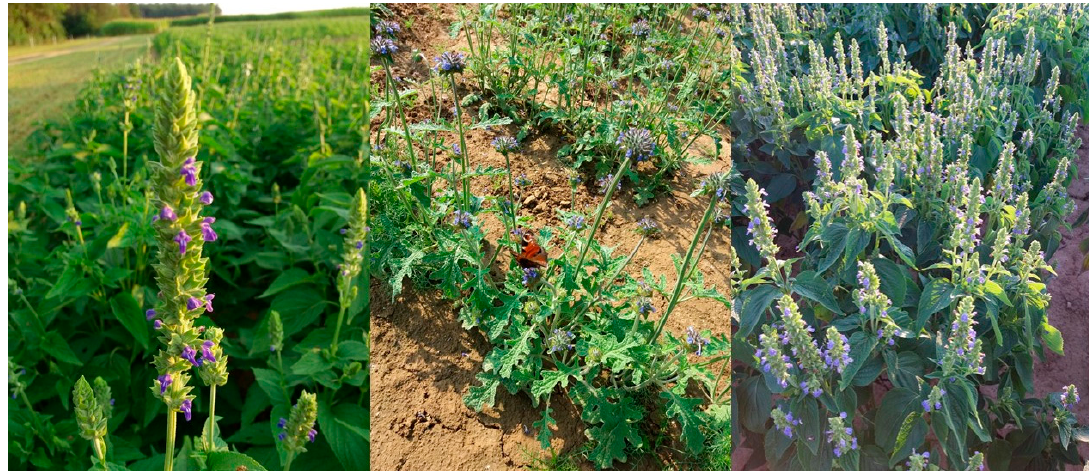
Figure 1. Inflorescences of Salvia hispanica L. (( left ) “G8”, ( right ) “SALV66”) and Salvia columbaria e Benth. (( middle ) “golden chia”) varieties.